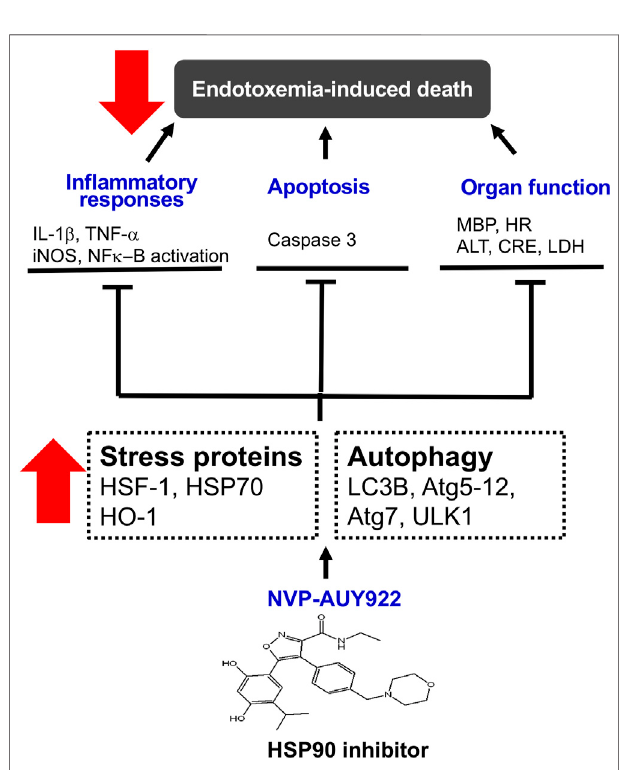
FIGURE 7 | Schematic diagram of the present study. NVP-AUY922, a novel HSP90 inhibitor, is able to orchestrate and facilitate autophagy, which is HSP70 and HO-1 dependent. It inhibits in fl ammatory response, and apoptosis, attenuates organ dysfunction and subsequently decreases morality in